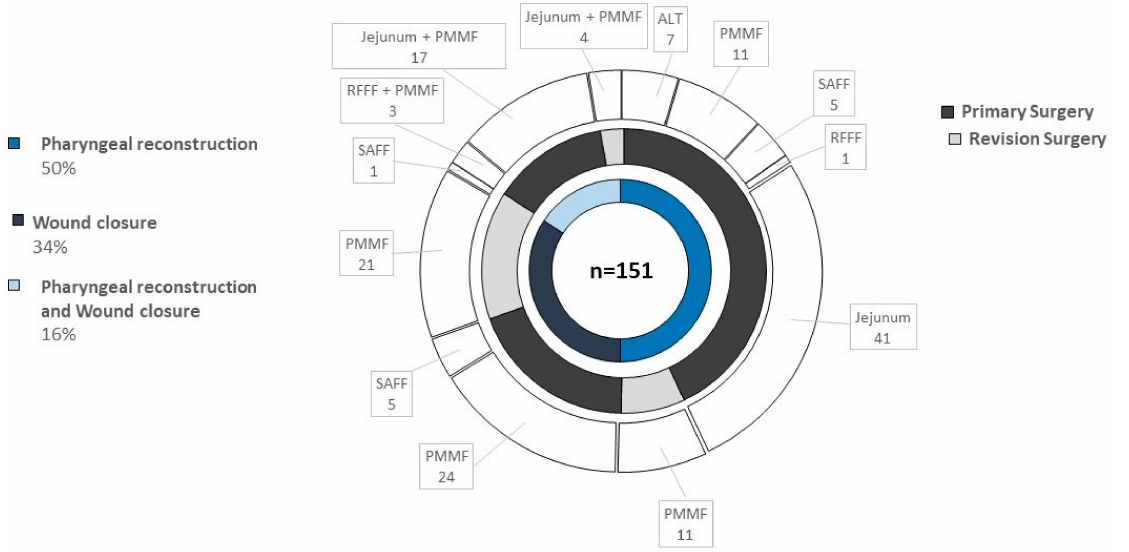
Figure 1. Type of flaps using for reconstruction after laryngopharyngectomy. Graphic representation as sunburst diagram with three ring diagrams. The inner ring displays the type of reconstruction, the middle ring illustrates the time point of reconstruction, and the outer ring shows the type of flaps used for